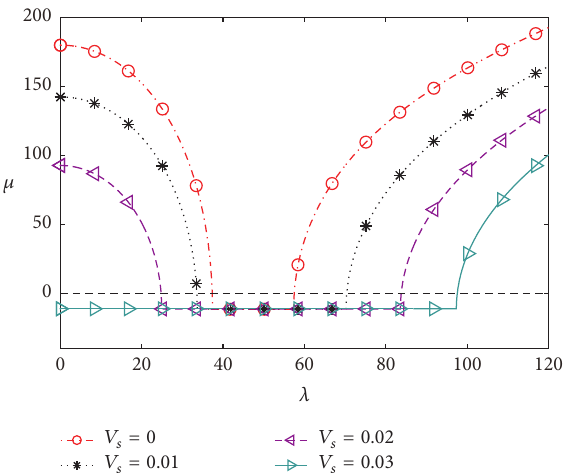
Figure 16: Influence of 𝑉 𝑠 on stability boundary.